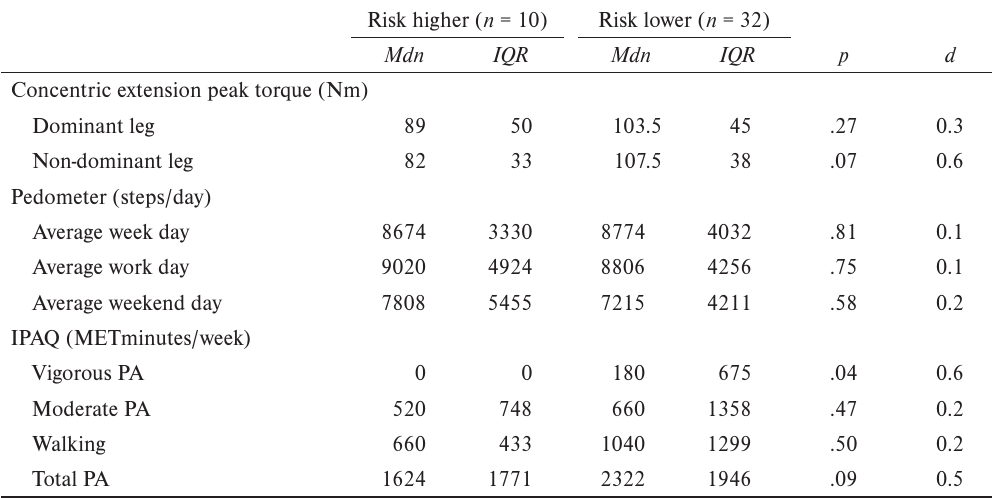
Table 1 Comparison of strength and PA in women being at higher and lower risk of falls associated with bilat- eral strength asymmetry of knee extensors Risk higher ( n =